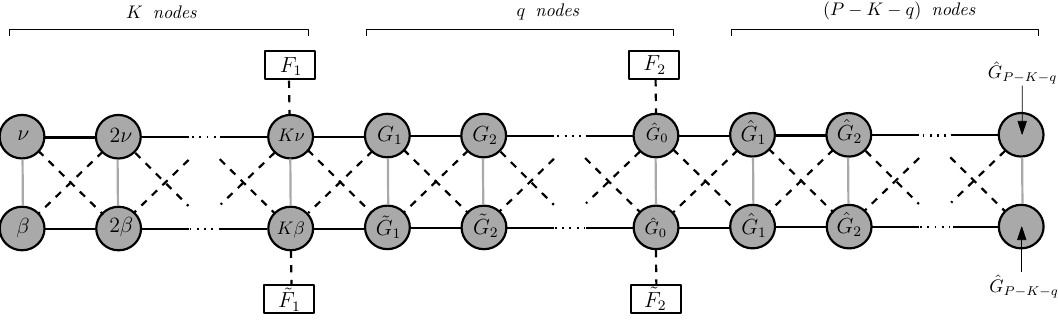
Figure 9 . A more complicated quiver with K linearly increasing rank nodes in each row, followed by q nodes with SU( G l ) and SU( ~ G l ) gauge groups in the top and lower rows, respectively, and ending with ( P (cid:0) K (cid:0) q ) nodes with SU( ^ G i ) gauge groups in both